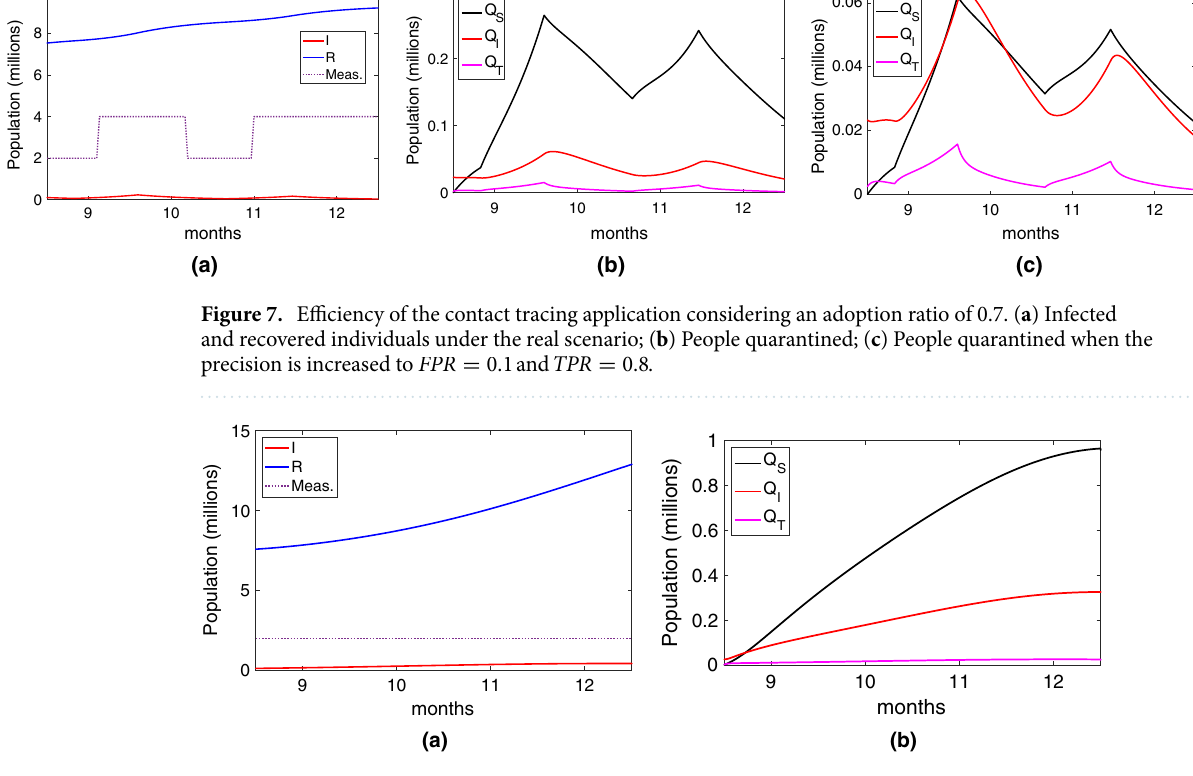
Figure 8. Contact tracing application efficiency considering that non stringent measures are taken and with excellent digital control tracing parameters: AR = 0.7 , TPR = 0.8 and FPR = 0.1 , TT = 1 . ( a ) Infected and recovered individuals; ( b ) People